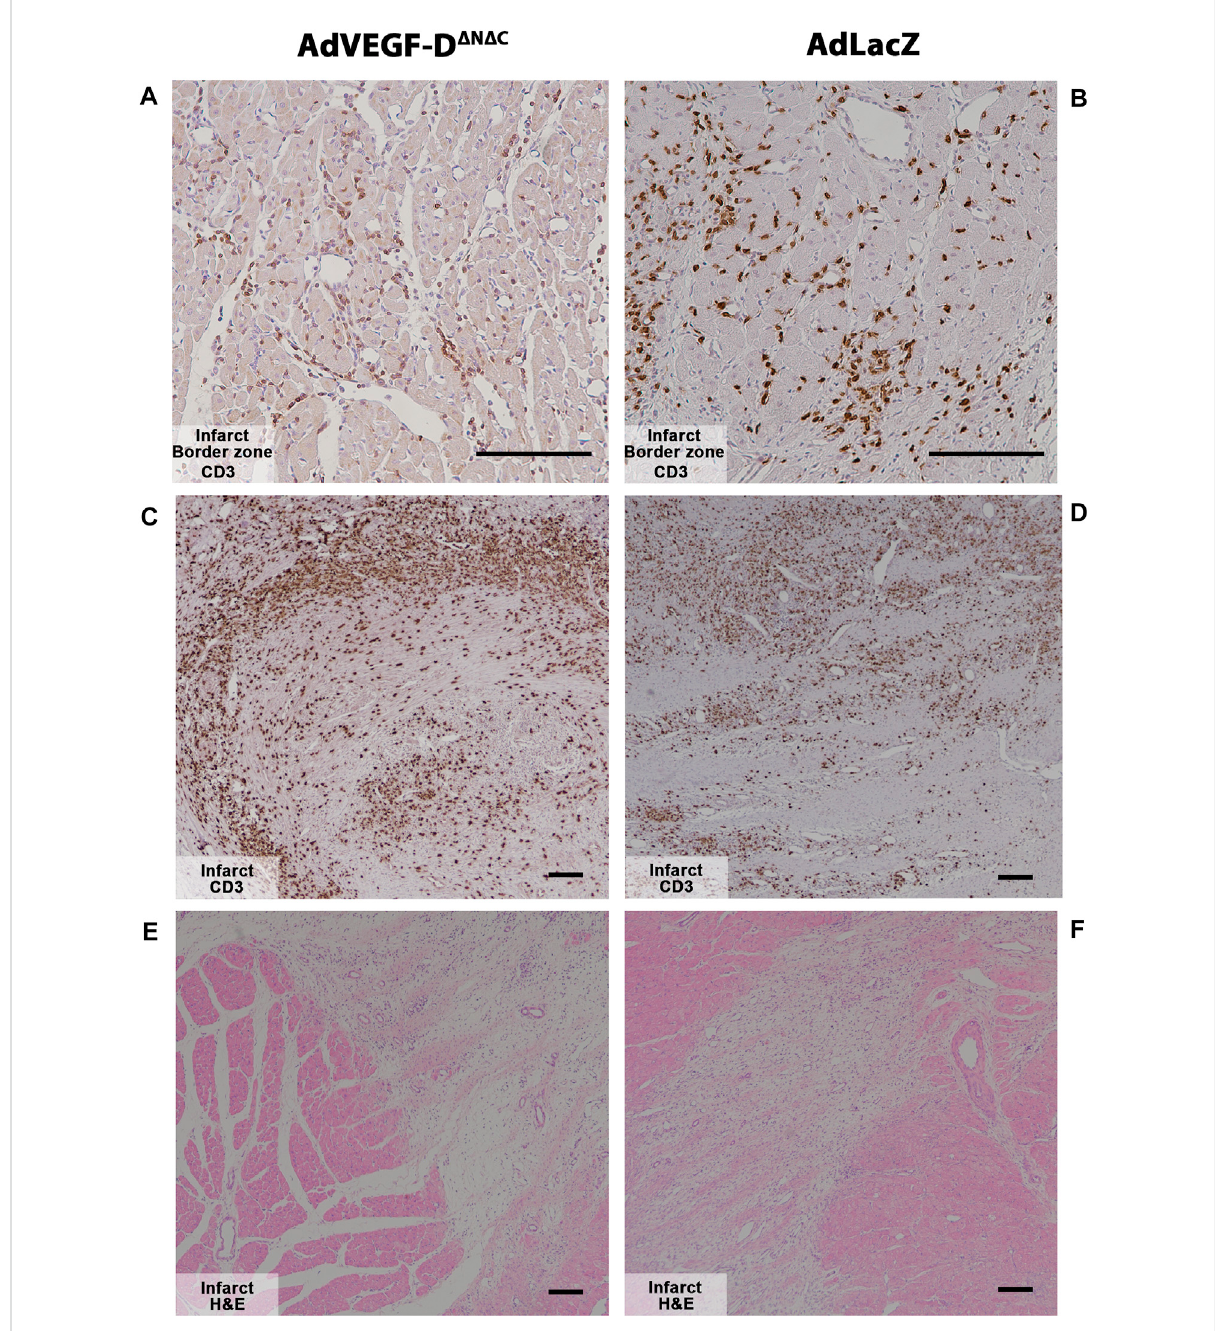
FIGURE 7 Myocardial infarction causes strong in fl ammatoryresponses inboth groups atday6. (A,B) AdVEGF-D Δ N Δ C and AdLacZ had no differences inthe in fl ammatory response in the infarct border zone. Magni fi cation ×200. (C – F) Myocardial infarct caused strong in fl ammatory responses in both groups. Magni fi cation ×40. CD3 — brown. Representative images. Scale bar 100